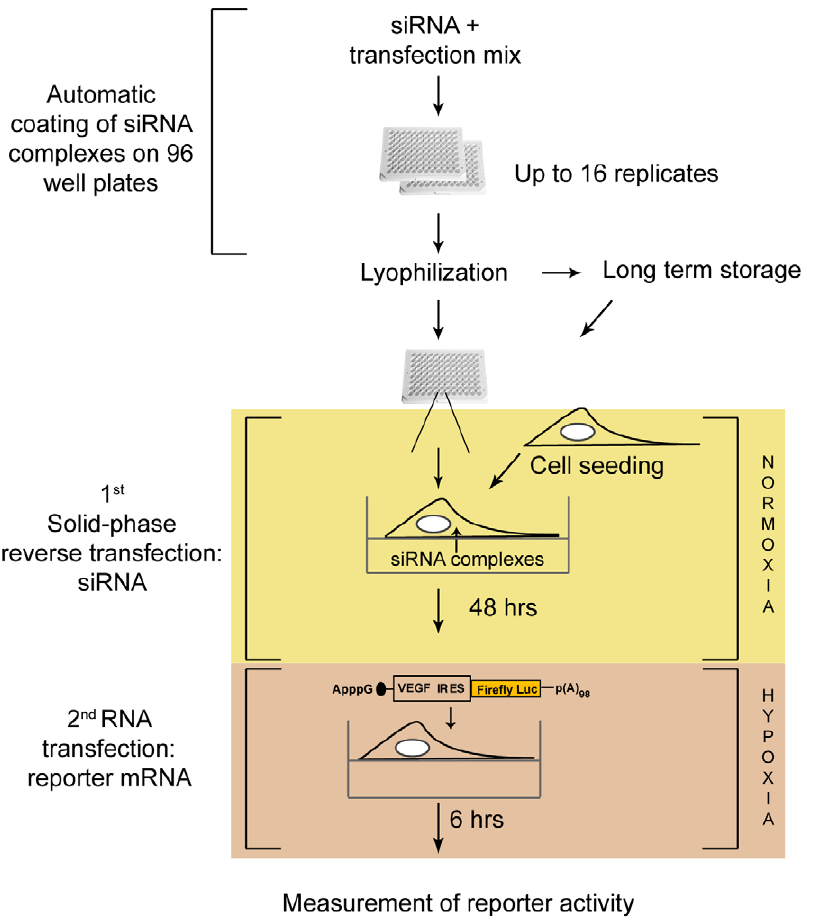
Figure 1. Workflow of the high-throughput siRNA screening approach to identify novel regulators of mRNA translation. The strategy features automated generation of lyophilized siRNA-coated 96 well plates, followed by two independent RNA transfections. Plates are first coated with siRNAs transfection mixes, cells are then seeded onto siRNA-coated plates (solid-phase reverse transfection) and incubated for two days to allow reduction of the protein levels of the targeted genes. Subsequently, a second RNA transfection is performed to introduce the reporter mRNA of interest. Finally, the effects of each siRNA knock-down are measured. VEGF IRES Fluc reporter mRNA activity (Fig. 4A, left panel), but had no effect on cap-dependent Fluc reporter mRNA activity (Fig. 4A, right panel). Mock and scrambled siRNA reverse transfection (negative controls) did not affect translation of either reporter. siRNAs targeting the Fluc coding sequence or Polo-Like Kinase 1‘‘ (PLK1) served as positive controls for RNAi efficacy. Both led to a reduction of Fluc levels for both IRES- and cap-